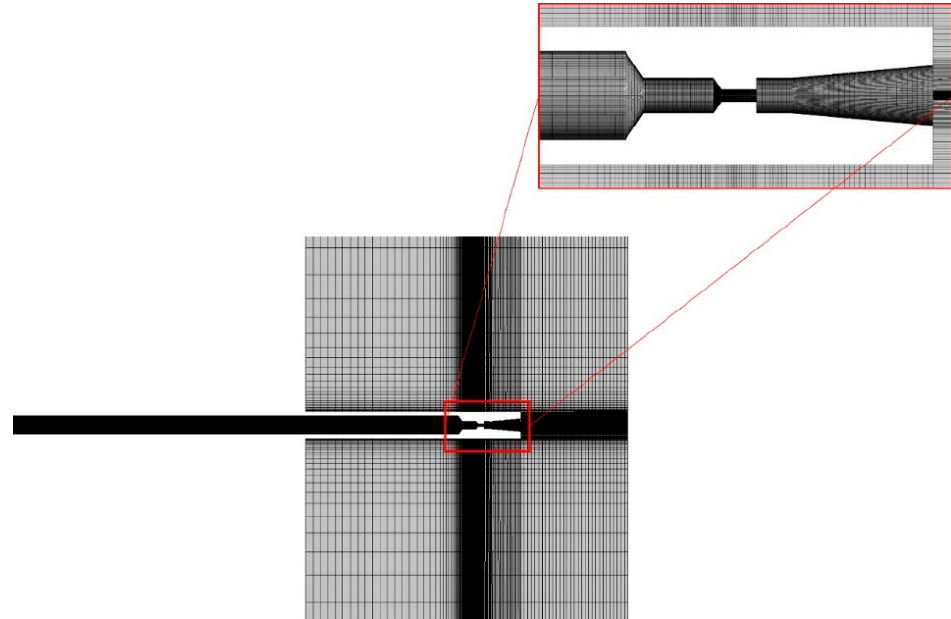
Figure 2. Mesh of the computational domain.